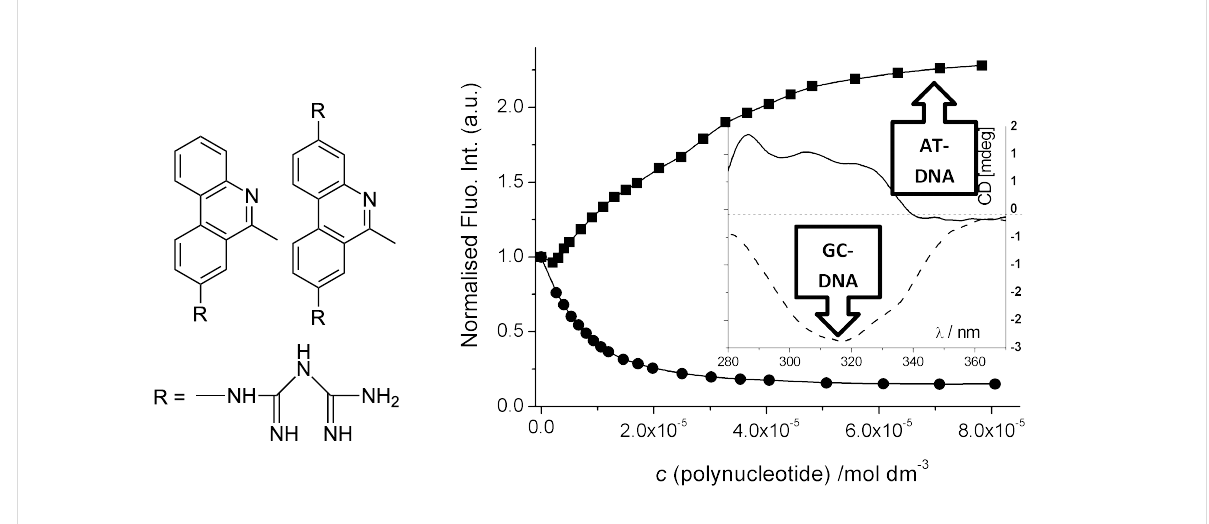
Figure 3: Structure of mono- ( 3 ) and bis-biguanide ( 4 ) derivative. Fluorescence (y-axis normalised to starting fluorescence of free 4, c = 1.0 × 10 − 6 mol dm − 3 ) was quenched by GC-DNA and increased for AT-DNA. Inset: induced (I)CD spectra λ > 280 nm of 4 (r( 4 )/DNA = 0.3; c (DNA) = 2 × 10 − 5 mol dm − 3 ) – strong positive ICD band for AT-DNA and negative ICD band for GC-DNA. Adapted with permission from [58]. Copy- right 2011 The Royal Society of